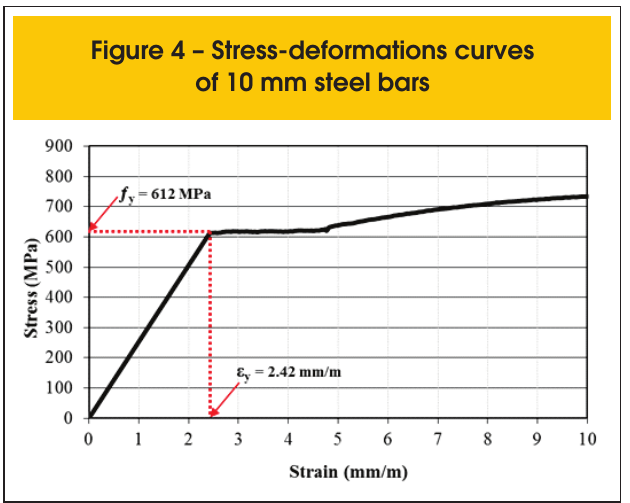
Figure 6 – Concrete compression strength of SCC with age curves